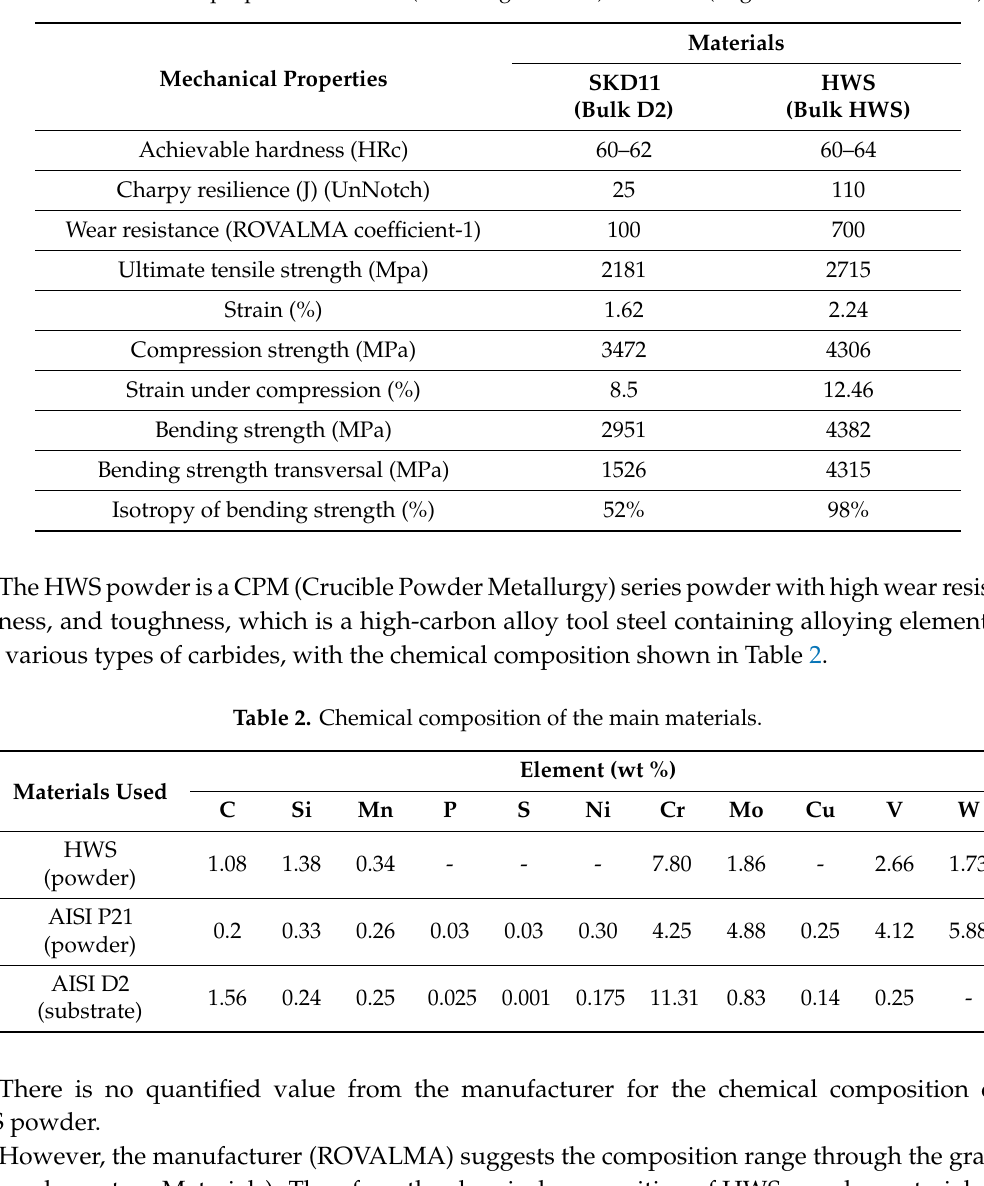
Table 1. Mechanical properties of SKD11(Steel Kogu Dice11) and HWS(High Wear resistance Steel).